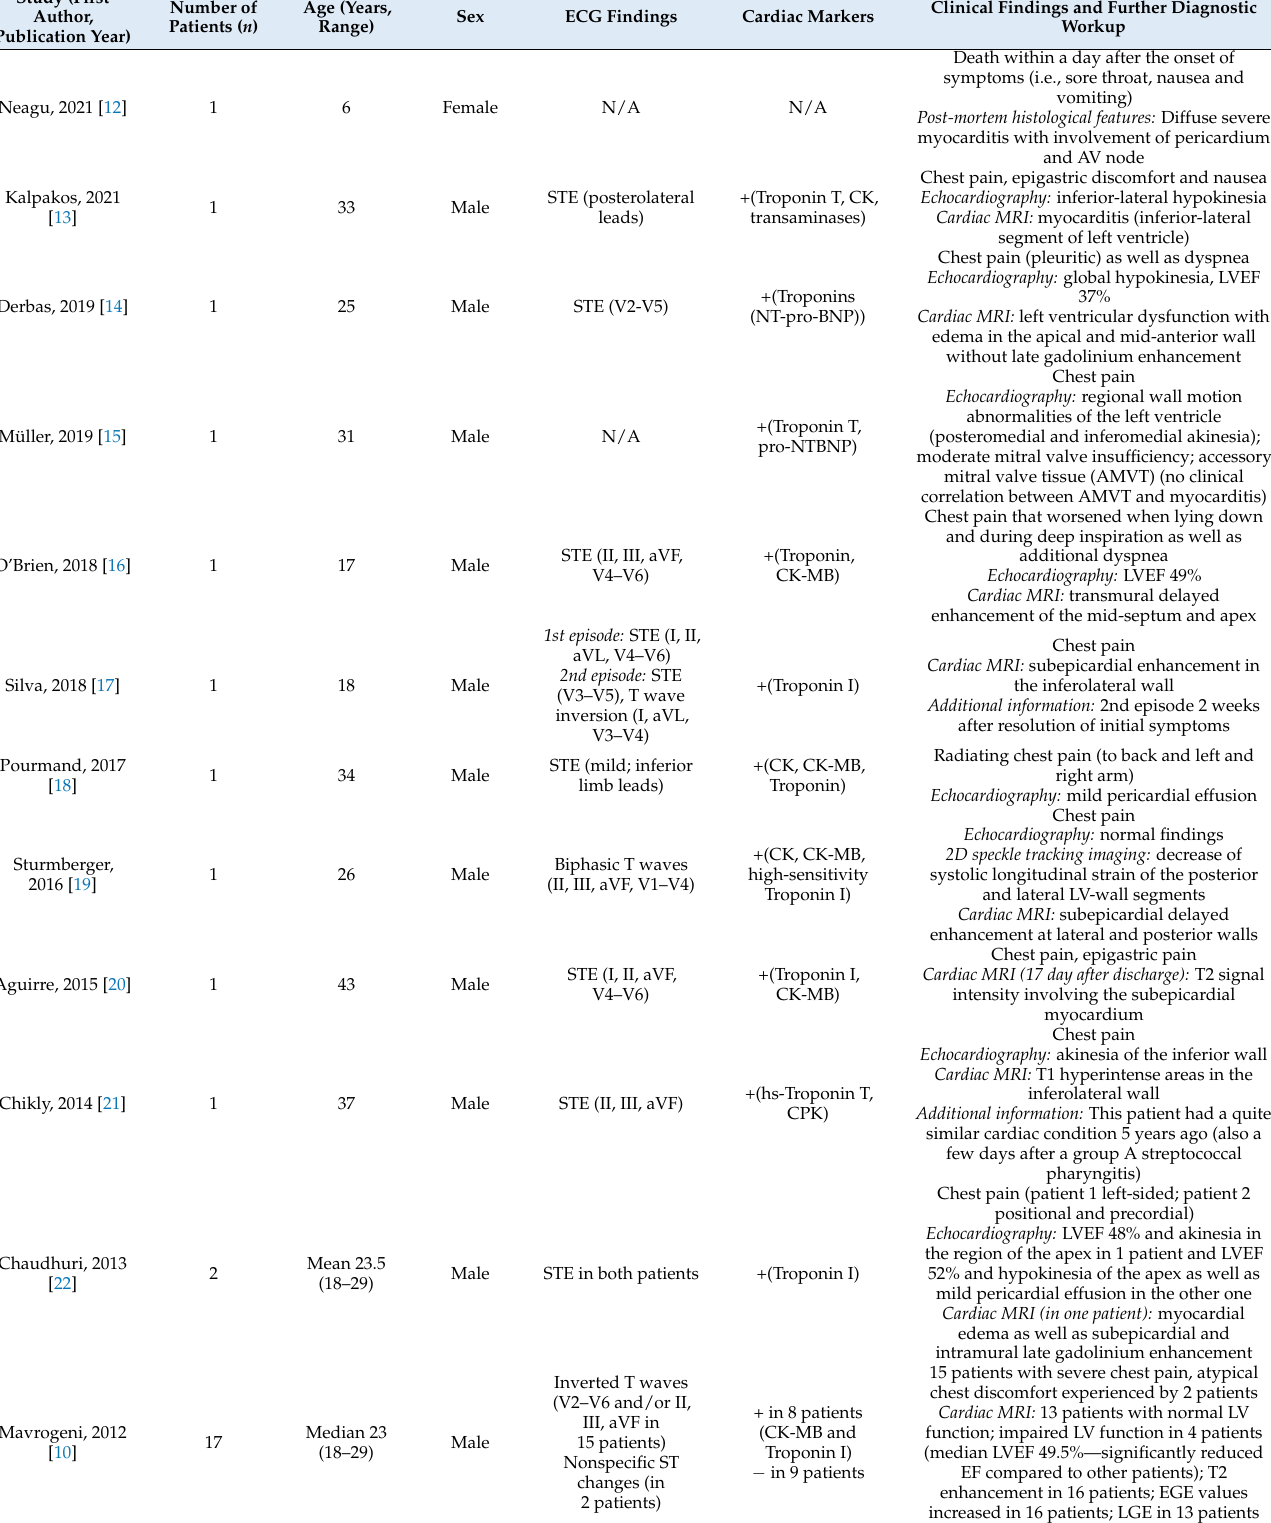
Table 1. Characteristics and principal findings of the studies included in this